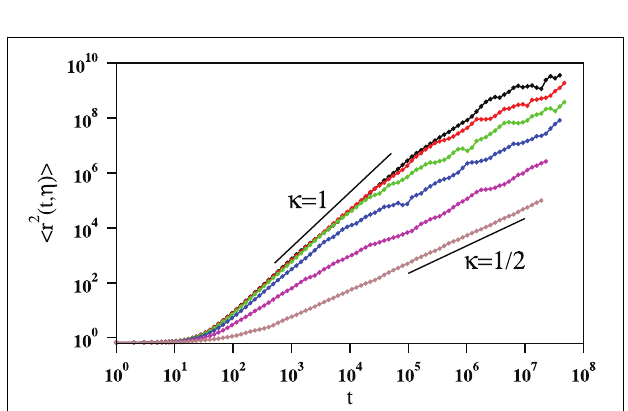
FIGURE 10 | The mean square displacement (cid:2) r 2 ( t , η ) (cid:3) of an agent from the origin has been plotted against time for different values of the noise parameter η = 0 . 2 (black), 0.5 (red), 1.0 (green), 2.0 (blue), 3.0 (magenta), and 4.0 (brown). The flock size N = 512 and the neighbor number n = 10. Two short straight lines are the guides to the eye whose slopes are κ = 1 / 2 and